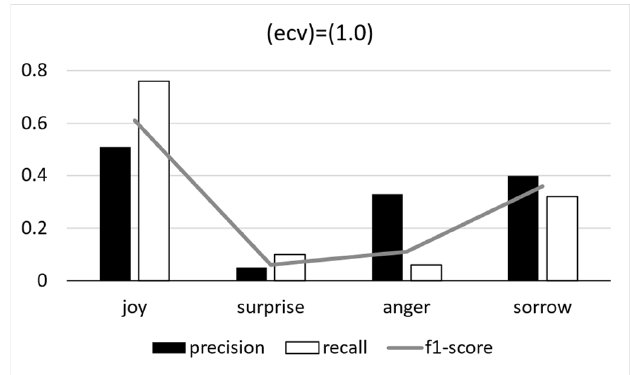
Figure 7. Result of baseline method; (ft) = (1.0).